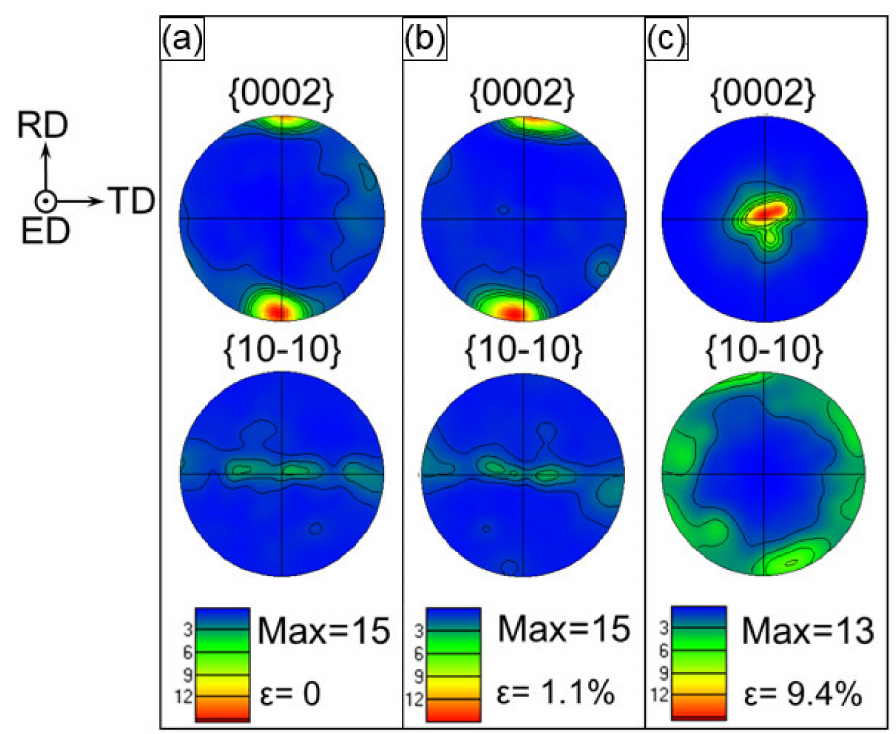
Figure 7. Stereographic pole figures illustrating the texture of the interface zone at di ff erent amounts of true strain at ( a ) 0%, ( b ) 1.1%, and ( c ) 9.4%, where the compression direction is parallel to the ED.